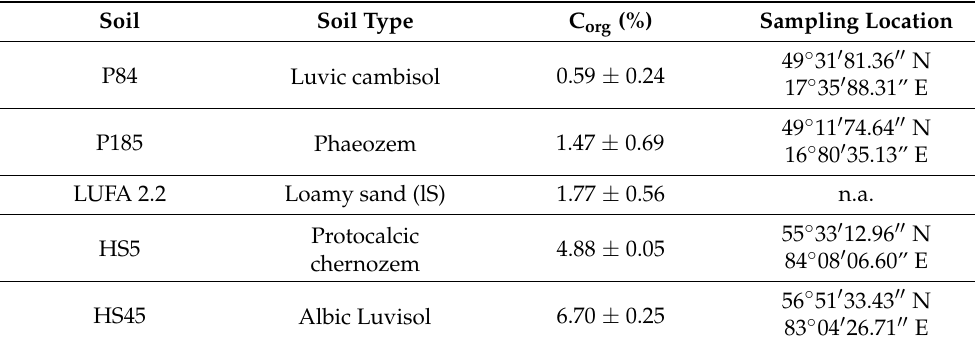
Table 1. Properties of soils used for experiments. Soil Soil Type C org (%) Sampling